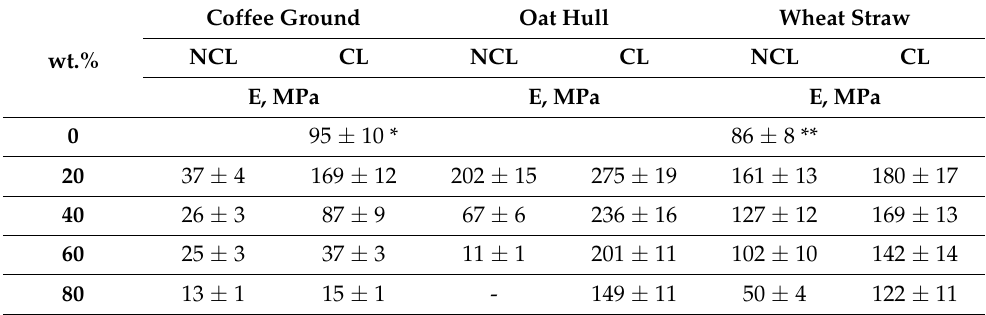
Table 4. Young ´ s moduli of hydrated chitosan-based biomass pellets in their crosslinked (CL) and non-crosslinked (NCL)